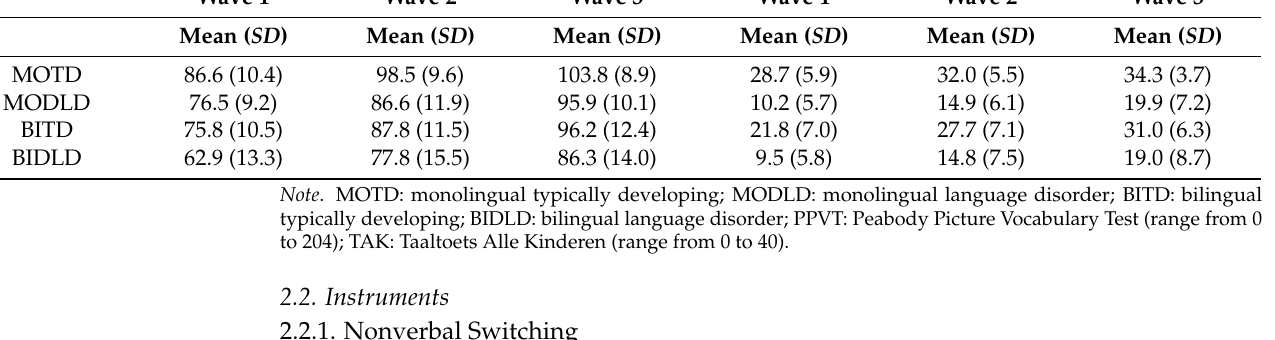
Table 2. Language skills of the four groups of participants (raw scores). PPVT TAK Sentence